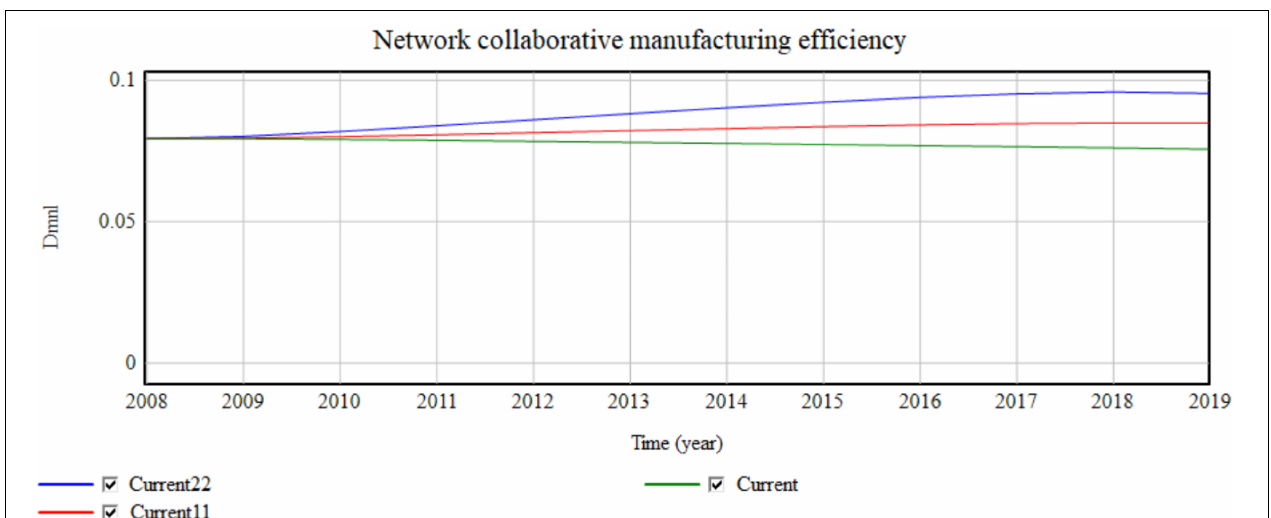
FIGURE 7 | Influence of micro value networks on business income.